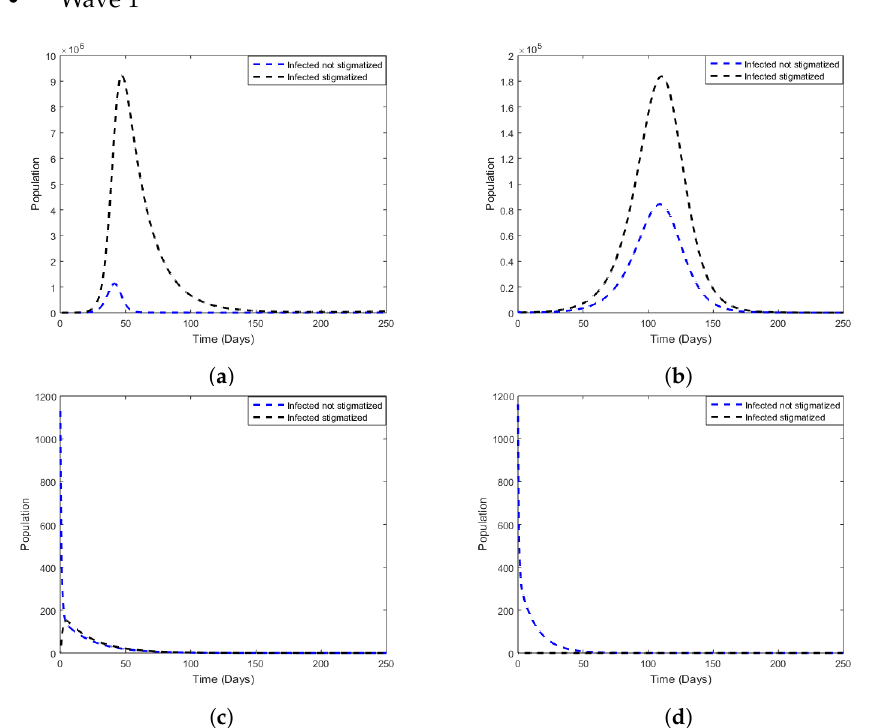
Figure 5. Comparison between non-stigmatised and stigmatised populations, varying γ for fixed values of p for the cases where there is stigma. ( a ) High stigma, γ = 0 and p = 0.49. ( b ) Moderate stigma, γ = 0.4 and p = 0.49. ( c ) Low stigma, γ = 0.8 and p = 0.49. ( d ) Stigma-free, γ = 0 and p =